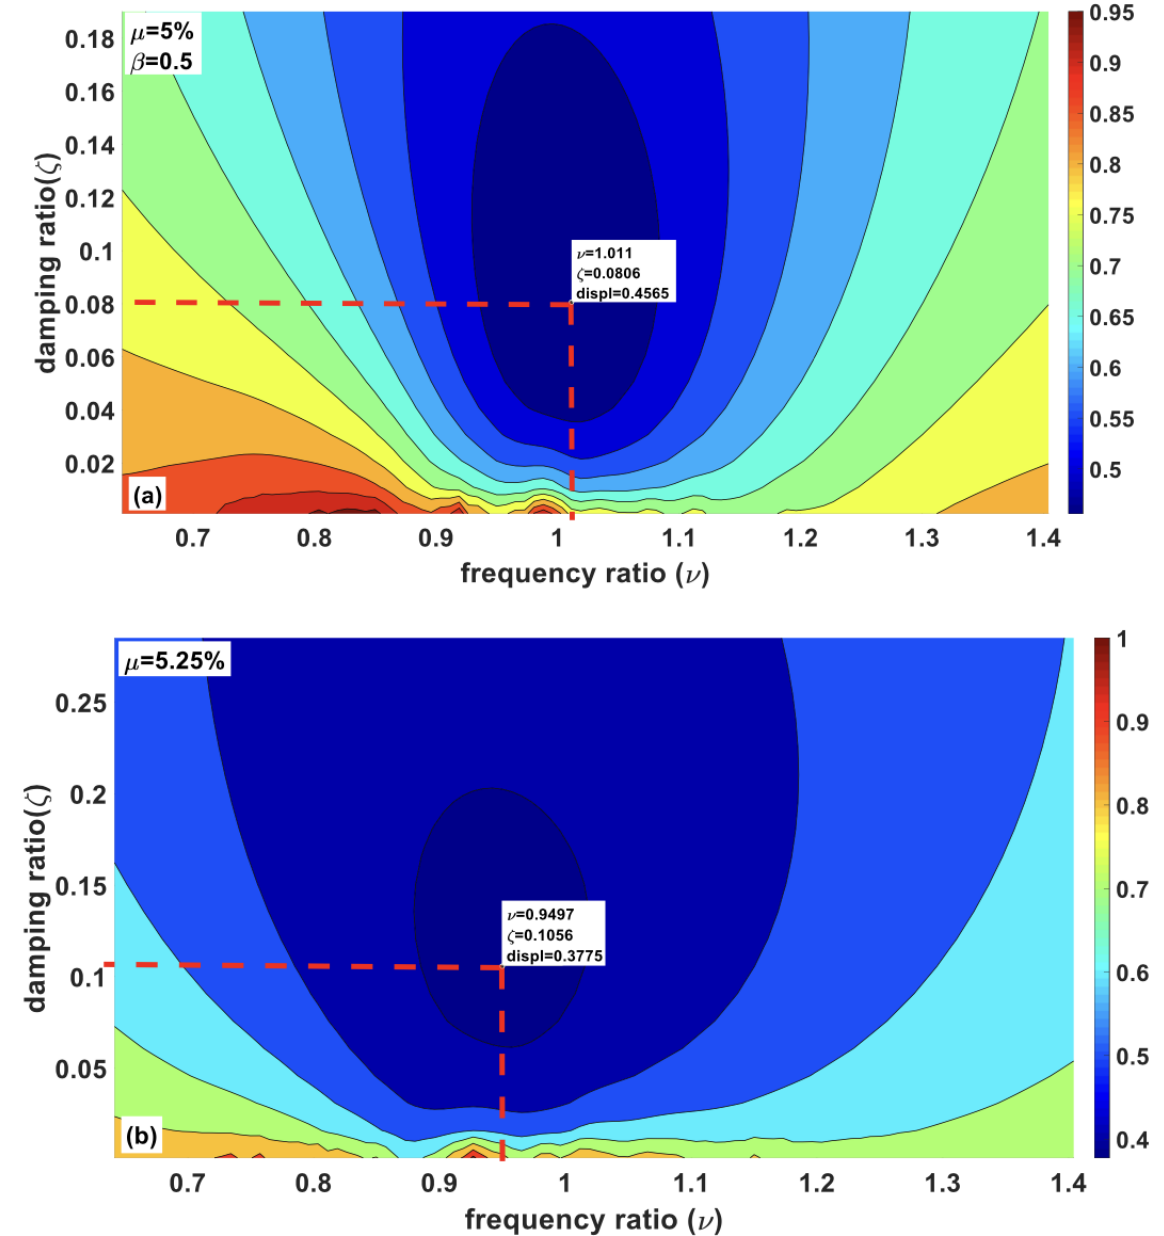
Figure 8. Optimization of TMDI (the mass ratio is 5% and the inertance ratio is 0.5) and equivalent TMD under filtered white noise excitation: ( a ) minimizing displacement at the top floor using TMDI, and ( b ) minimizing displacement at the top floor using equivalent TMD.